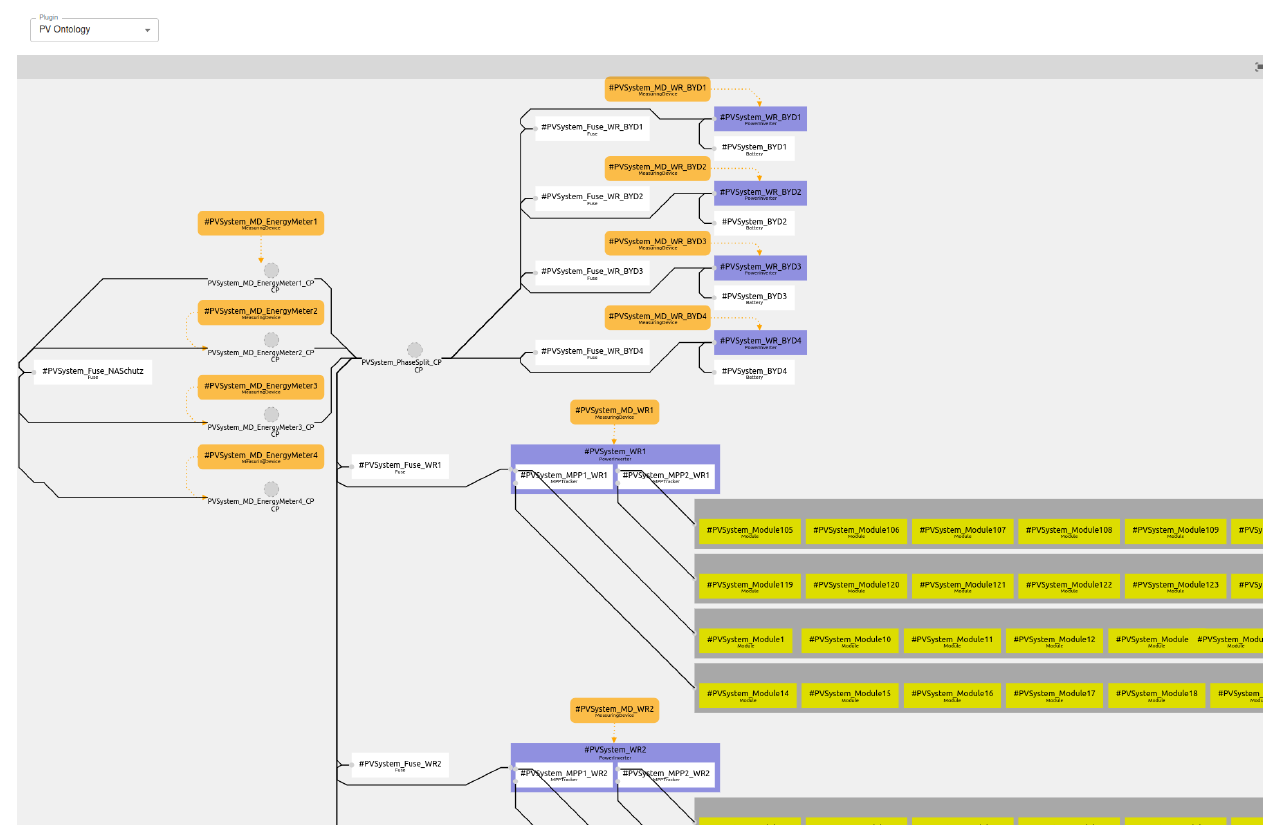
Figure 6. Screenshot of the PVOntology Plugin Visualizing the PV